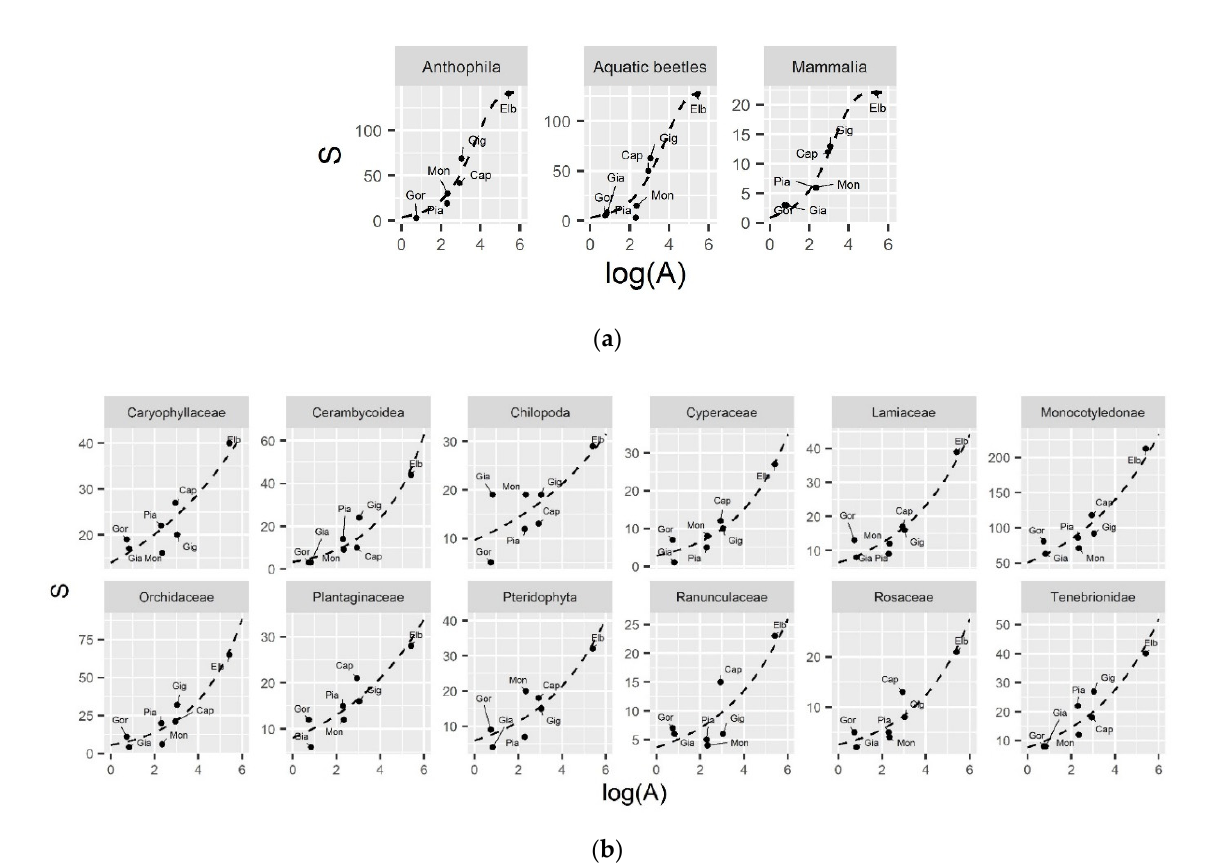
Figure 2. ( a ) Species-Area Relationship (SAR) according to the Negative exponential function: Effect of the logarithm of island area on species richness (S) of Anthophila, Aquatic beetles and Mammalia in the Tuscan Archipelago. ( b ) SAR according to the Logarithmic function: Effect of the logarithm of island area (log(A)) on species richness (S) of animal and plant taxa in the Tuscan Archipelago. Table 4. Estimates of the Species–Area Relationship (SAR) coefficients modeled by the Negative exponential function. SE: Standard error of the estimate; t-value: Student’s t value; Pr(>|t|): Two- tailed p -values testing the null hypothesis that the coefficient is equal to zero.